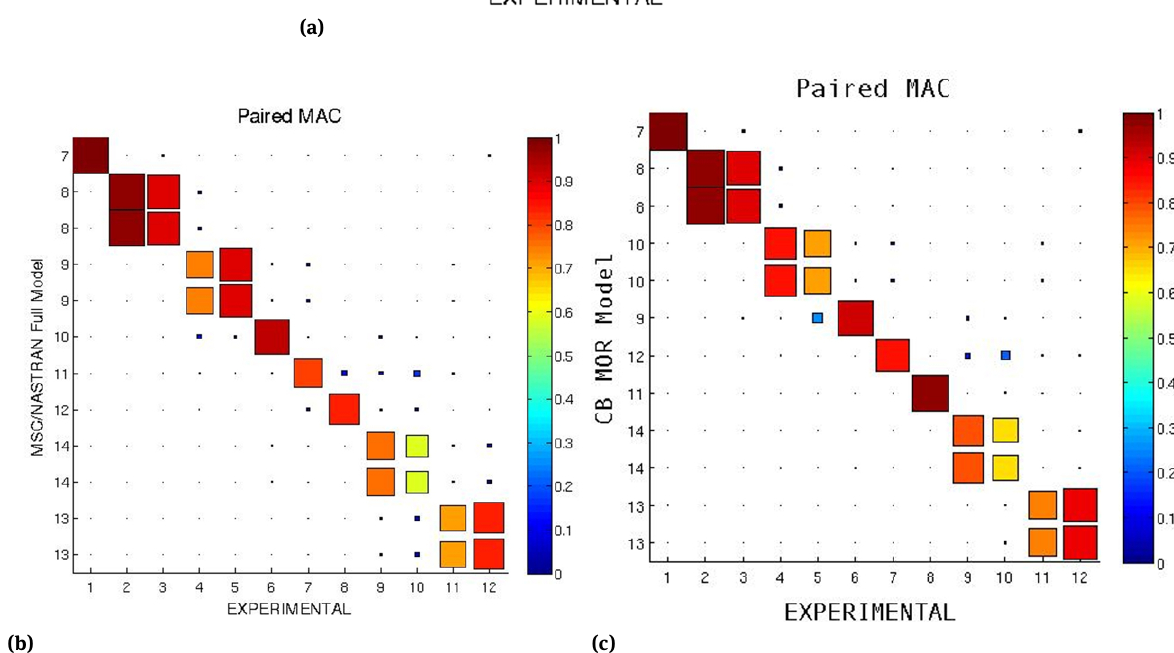
Figure 3: Comparative MAC: a) SDtools-Exp, b) MSC/NASTRAN-Exp, c) CBMOR-Exp